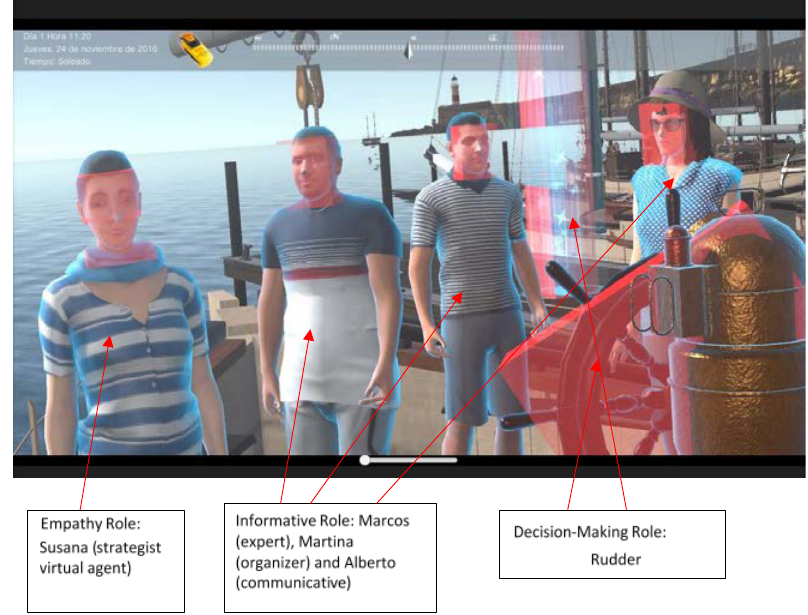
Figure 2. Basic roles: active and passive.